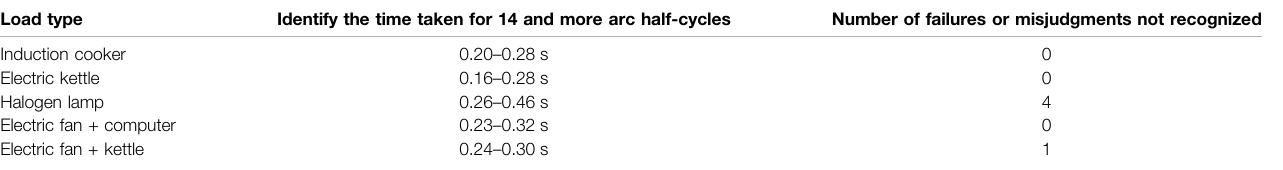
TABLE 7 | Non-training set load detection